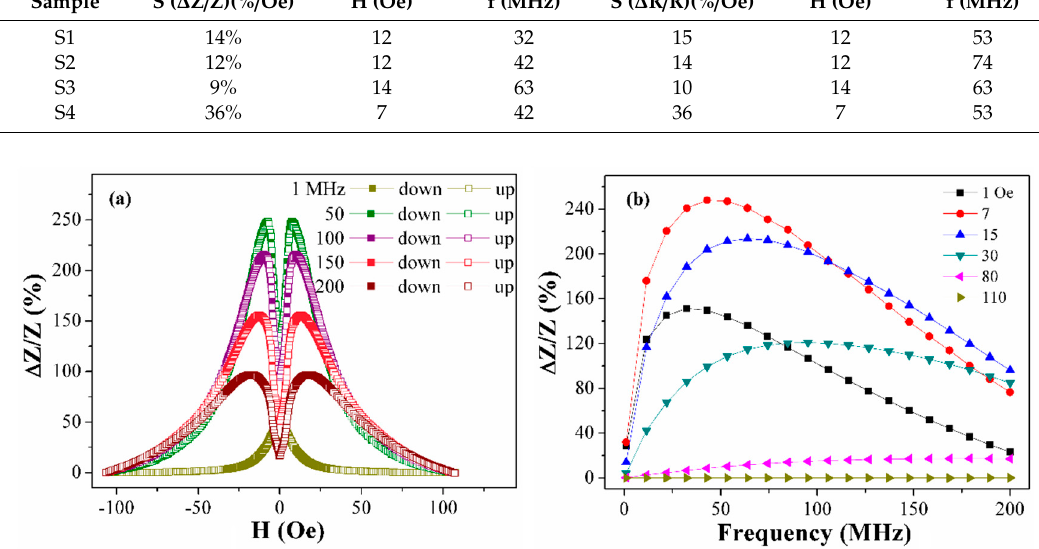
Figure 9. ( a ) Field and ( b ) frequency dependence of the MI ratio of Co 75 Fe 10 Ni 2 Si 8 B 5 patterned meander element S4.